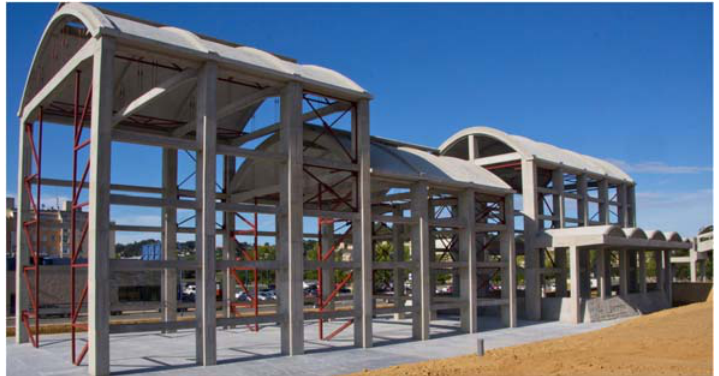
Figure 2. General view of the structure after repair (photo courtesy of Diaz & Diaz Architects S.L.).